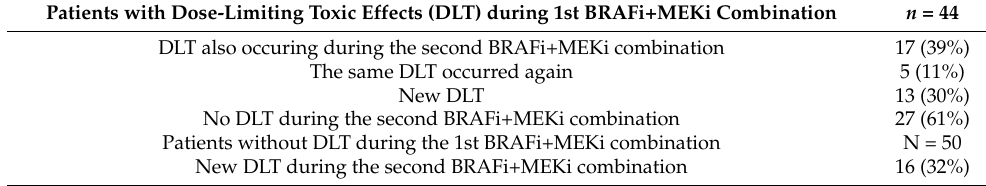
Table 3. Summary of dose-limiting toxicities (DLT) occurring during the second BRAFi+MEKi combination in patients with or without previous DLT during the first combination. One patient had a recurrent case of the same DLT as well as a new